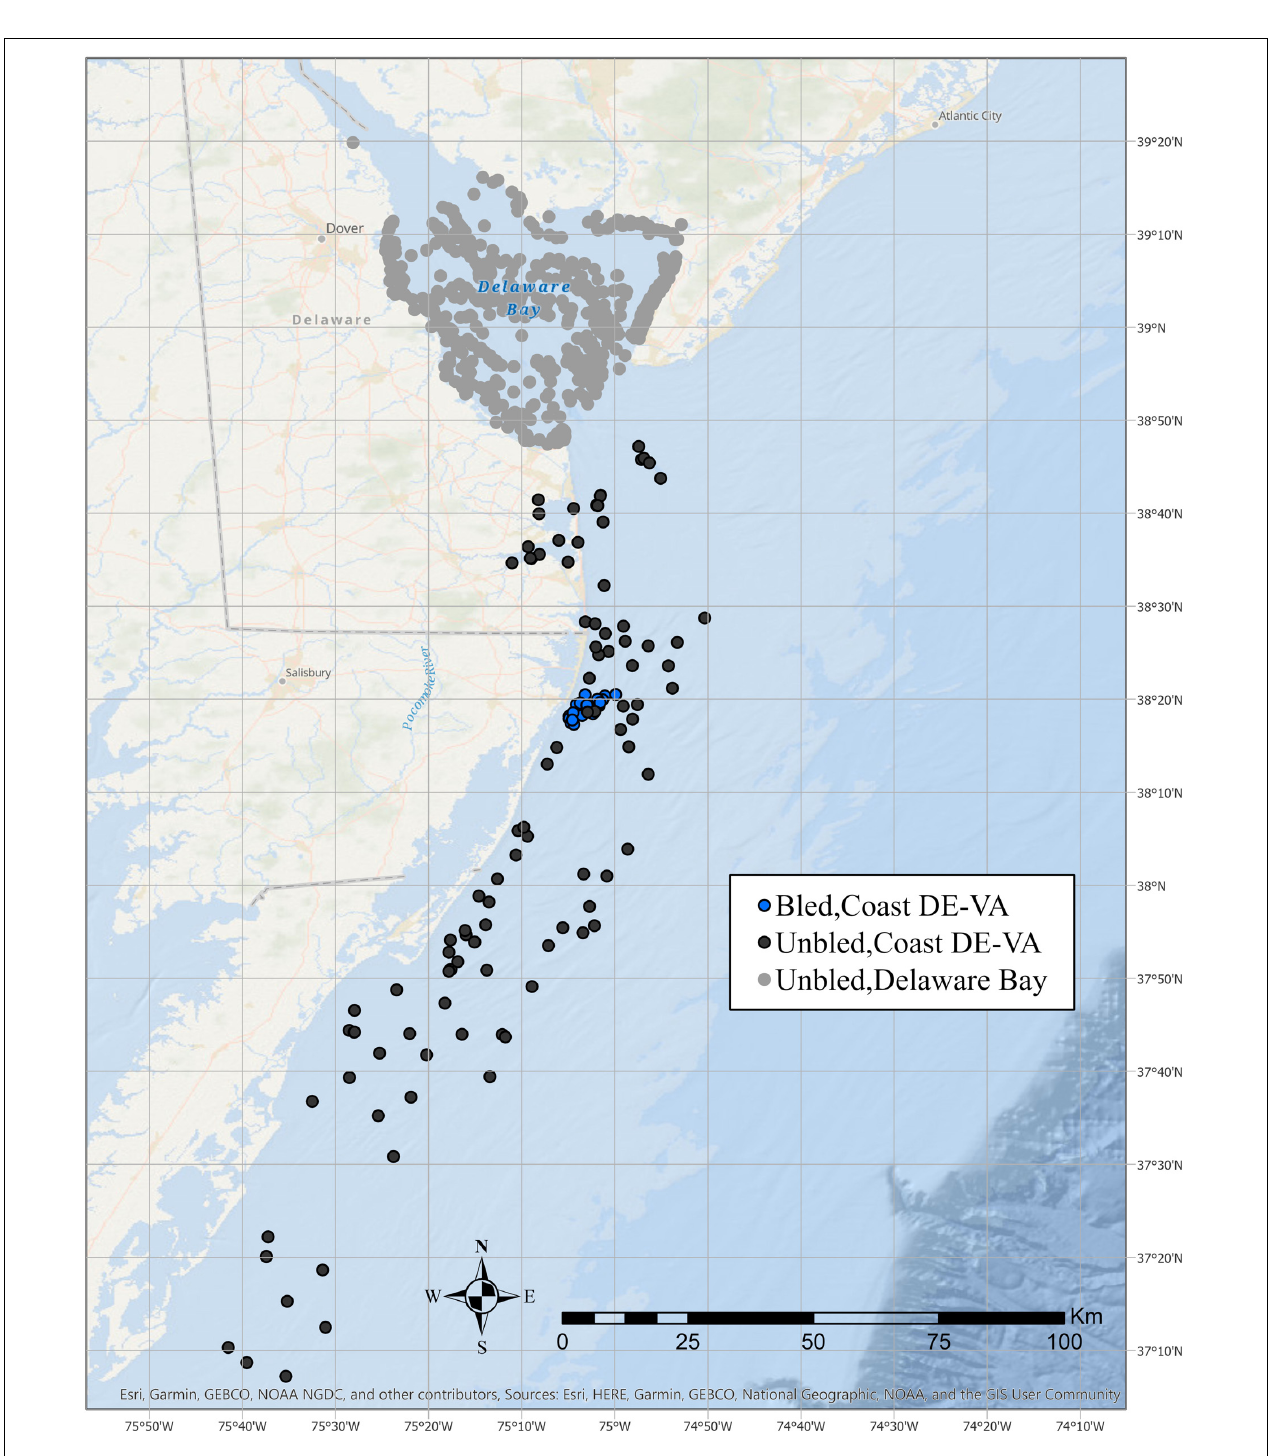
FIGURE 1 | Tag release locations in coastal Delaware to Virginia and Delaware Bay for adult horseshoe crabs that were bled for LAL or not bled.